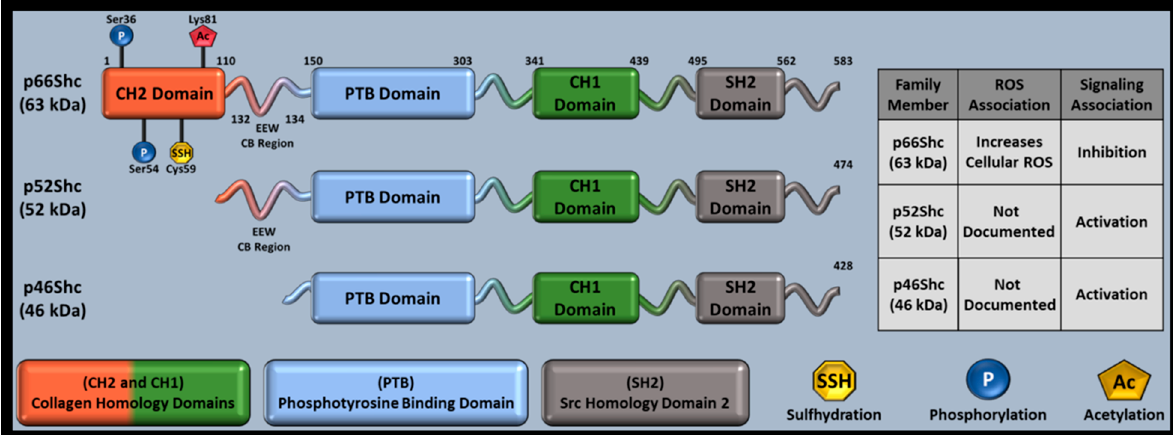
Figure 1. ShcA family modular structure and CH2 domain post-translational modifications affecting ROS output. All ShcA proteins have SH2, CH1, and PTB domains but differ by CH2 domain length. p66Shc has a unique set of promoters and is tied to oxidative stress or Ras inhibition. p52/46Shc share a set of promoters, do not have documented ROS activity, and promote cell cycle progression and differentiation. Important ROS-related PTMs include Ser36 phosphorylation (mitochondrial translocation), Ser54 phosphorylation (decreased proteasome degradation), Cys59 sulfhydration (decreased Ser36 phosphorylation), and Lys81 acetylation (increased Ser36 phosphorylation).